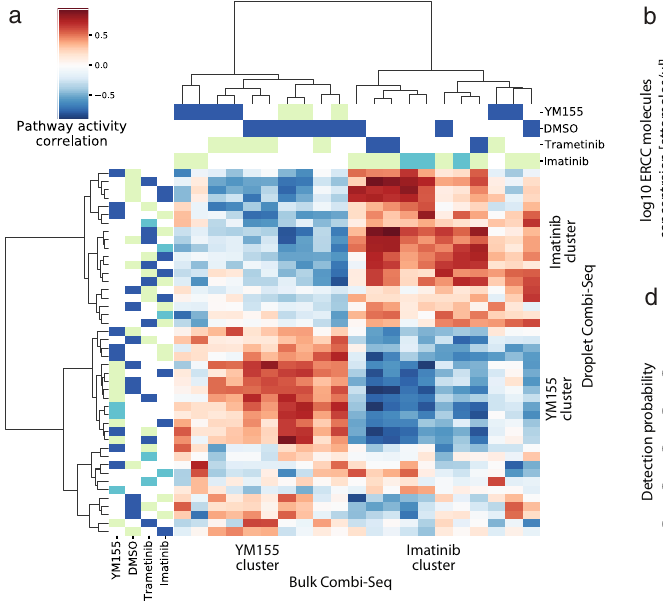
Fig. 4 | Assessing the robustness, sensitivity, and accuracy of Combi-Seq. a Heatmap of correlations between pathway activities of bulk and droplet Combi- Seq data: PROGENy pathway activities were determined for each sample and cor- relationsformatchedsamplesusingeitherdataobtainedinmicrotiterplates(rows) ordroplets(columns)werecalculated(colorcodebluetored)andusedtoperform hierarchical clustering. Drugs of combinations are color-coded (light green: Auto- sampler drug, blue: Braille valves drug, cyan: Same drug from autosampler and Braille valves). b Accuracy of spike-in detection as a correlation between ERCC input concentration and measured transcripts per million (TPM) for 250 cells per sample, shaded area shows 95% con fi dence interval of the regression estimate. ( c